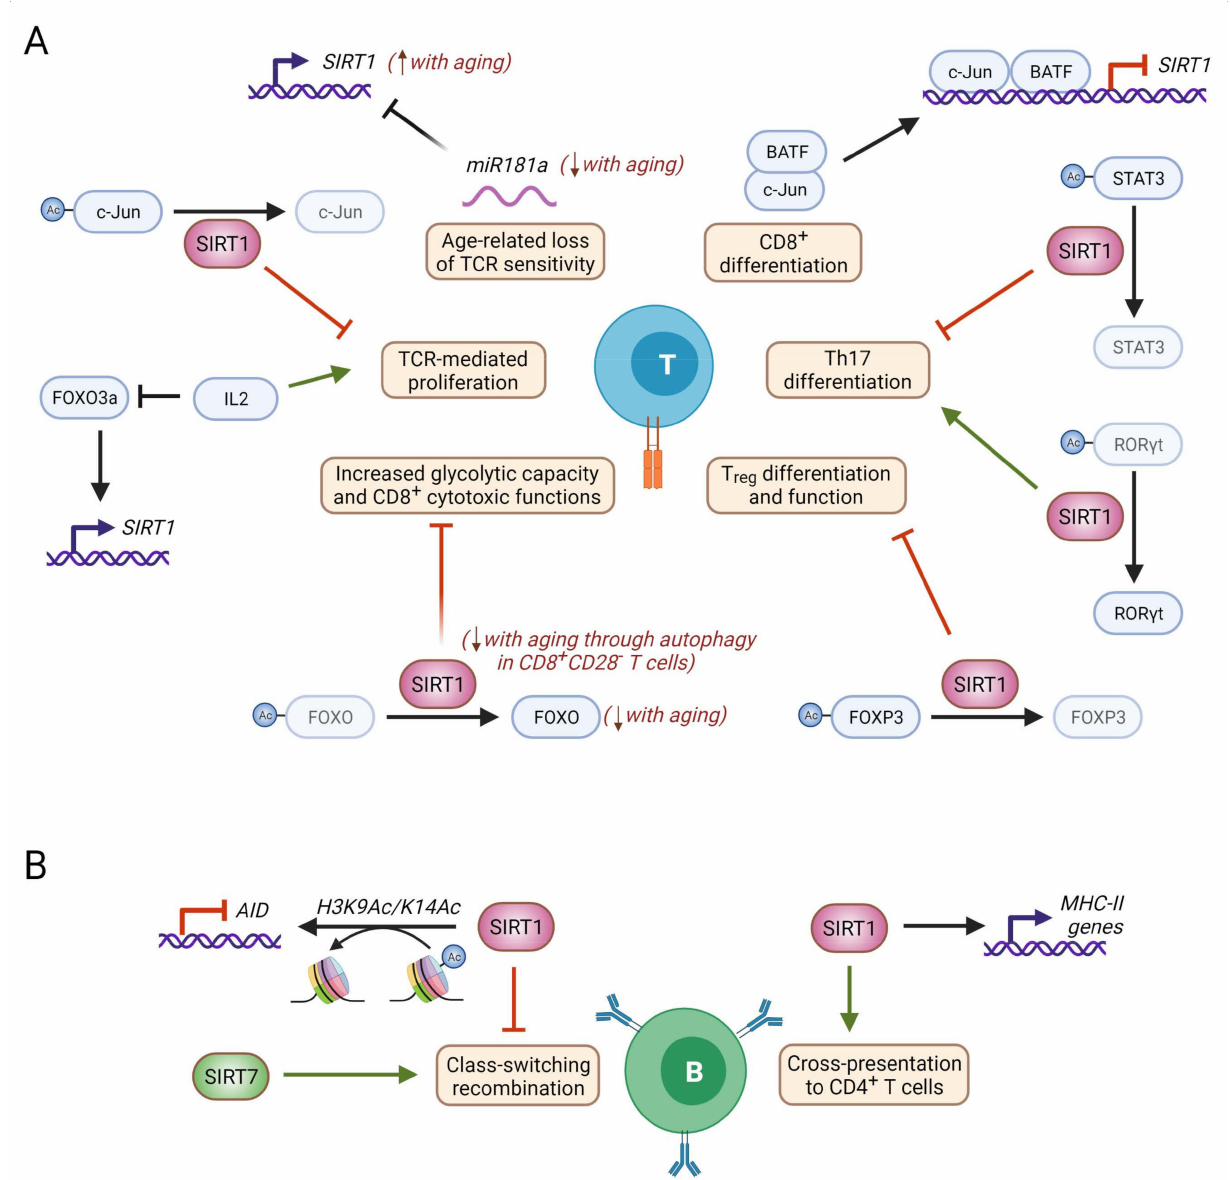
Figure 6. Molecular mechanisms of nuclear sirtuin activity in B and T cells. ( A ) SIRT1 negatively regulates TCR-mediated T cell activation through deacetylation of the AP-1 member c-Jun [40,95–97]. Conversely, IL-2 induces exit from anergy